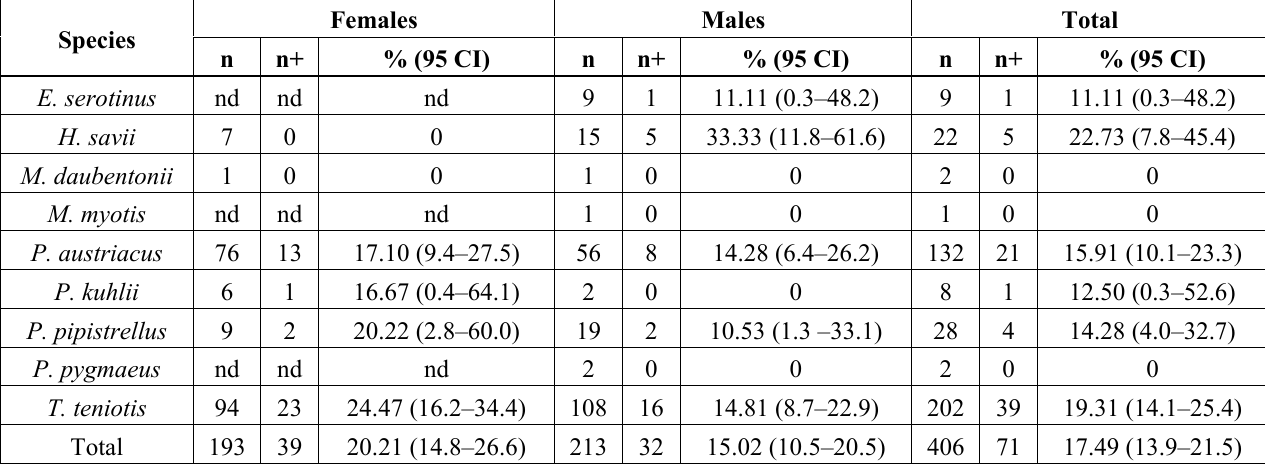
Table 1. The serological results of European Bat Lyssavirus Type 1 (EBLV-1) neutralizing antibodies analyzed by all bat species captured in the San Pedro de los Griegos pothole (2004–2012).